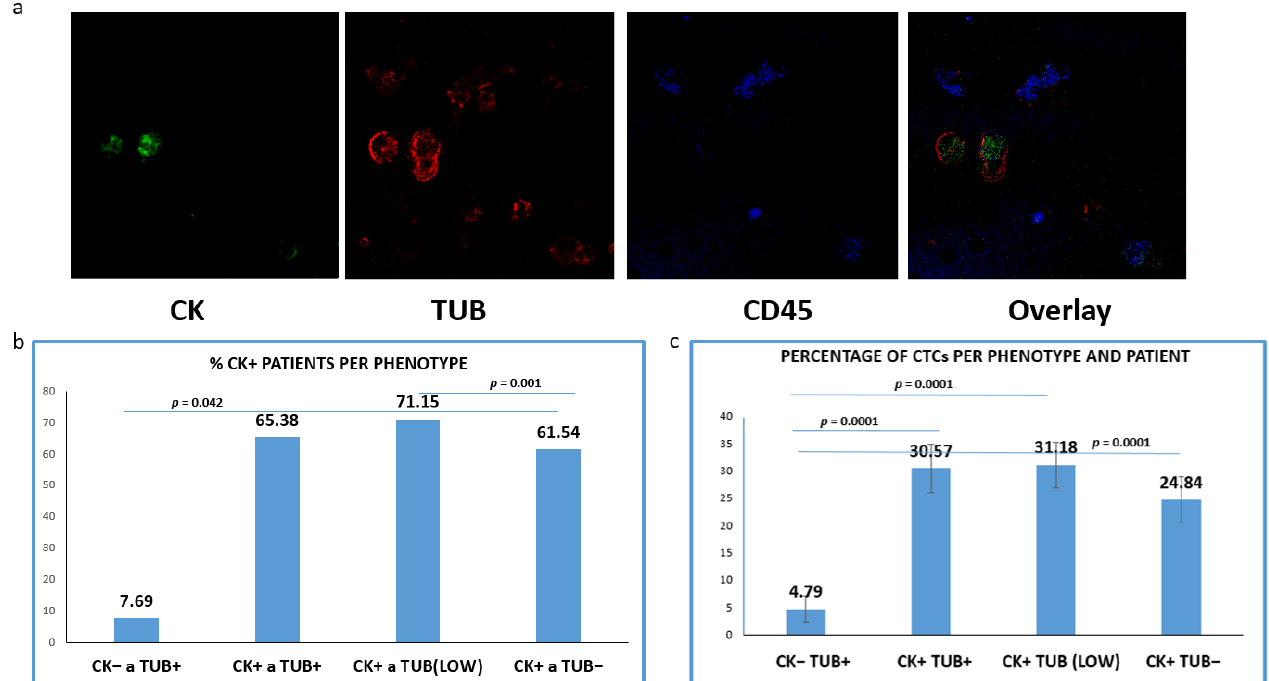
Figure 2. Expression of Cytokeratin (CK) and alpha- Tubulin (TUB) in patients’ CTCs . ( a ) Representative confocal laser scanning micrographs of patients’ CTCs ( ×40) stained for CK (green), Tubulin (red), CD45 (blue) and DAPI (not shown because our confocal has no laser for DAPI); ( b ) Percentages of patients belonging to distinct phenotypes. Each patient was considered as positive for a distinct phenotype, if he/she is harboring at least one CTC with this phenotype; ( c ): Percentage of CTCs per patient and per phenotype in the whole examined group of subjects.